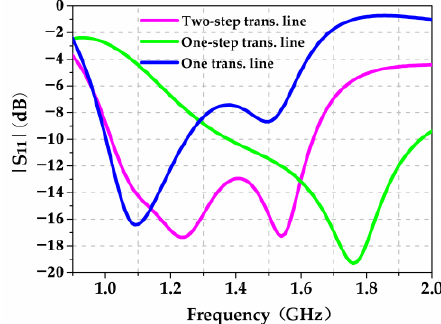
Figure 4. Simulated | S 11 | with three different feeding sheets .